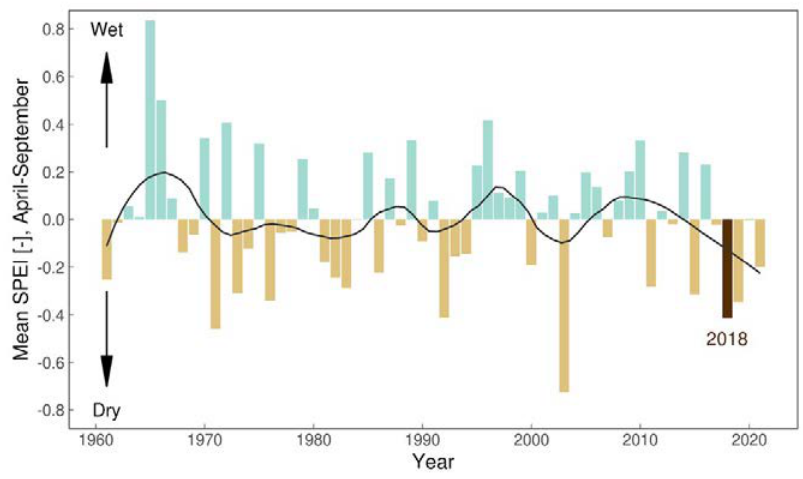
Figure 5. Annual averages of the SPEI (Standardized Precipitation Evapotranspiration Index) for a 30-day accumulation window) for the period April 1st to September 30th. Negative (positive) values denote dryer (wetter) than normal conditions; the year 2018 is highlighted in brown.